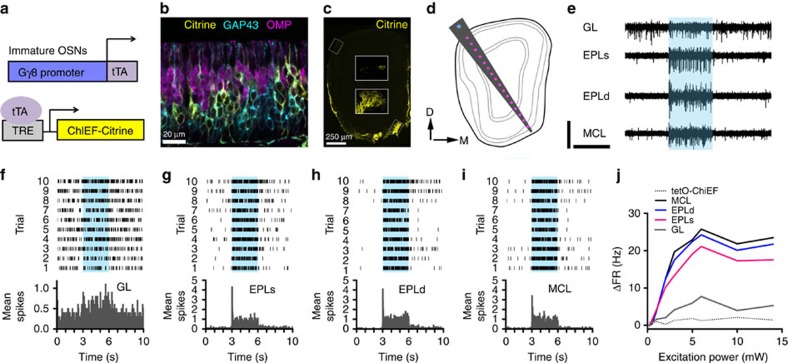
Optogenetic photoactivation of immature OSN axons evokes robust firing of OB neurons.(a) Schematic representation illustrating generation of transgenic mice expressing ChIEF-Citrine in immature OSNs using the tTA system. (b) Confocal image of coronal section of olfactory epithelium from P16 Gγ8-ChIEF-Citrine mouse showing colocalization with GAP43 (98.5%) and OMP (6.2%; n=1,106 Gγ8+ OSNs from three mice). 49.7% (1,106/2,225, n=3 mice) of GAP43+ neurons expressed Citrine. (c) Widefield fluorescence image of coronal OB section showing ChIEF-Citrine expression in olfactory nerve layer and GL of the same mouse as in b. Inset: maximum intensity projections of confocal z-stacks for boxed regions. (d) Schematic representation of multi-channel recording experiment. Optrode consisted of 16 electrodes (pink) with 100 μm spacing and an optical fibre (blue) terminating 200 μm above the most superficial electrode. D, dorsal; and M, medial. (e) Example traces from deepest four electrodes in a Gγ8-ChIEF-Citrine mouse showing robust multi-unit firing during photoactivation (blue band) in the GL, EPL (superficial and deep) and MCL. Scale bars, 10 μV, 1 s. (f–i) Raster plots and peri-stimulus time histograms (20 ms bins) for trials using an excitation power of 10 mW for the same mouse shown in e; traces correspond to trial 1. (j) Relationship between excitation power (473 nm) and mean change in firing rate (ΔFR) for neurons in GL, EPL and MCL in Gγ8-ChIEF-Citrine mice (n=5, mean values shown). GL P<0.001; EPLs P<0.001; EPLd P=0.003; MCL P=0.006; and Gγ8-ChIEF-Citrine versus tetO-ChIEF-Citrine, two-way ANOVA. tetO-ChIEF-Citrine data shown as mean values across all four electrodes (n=3).